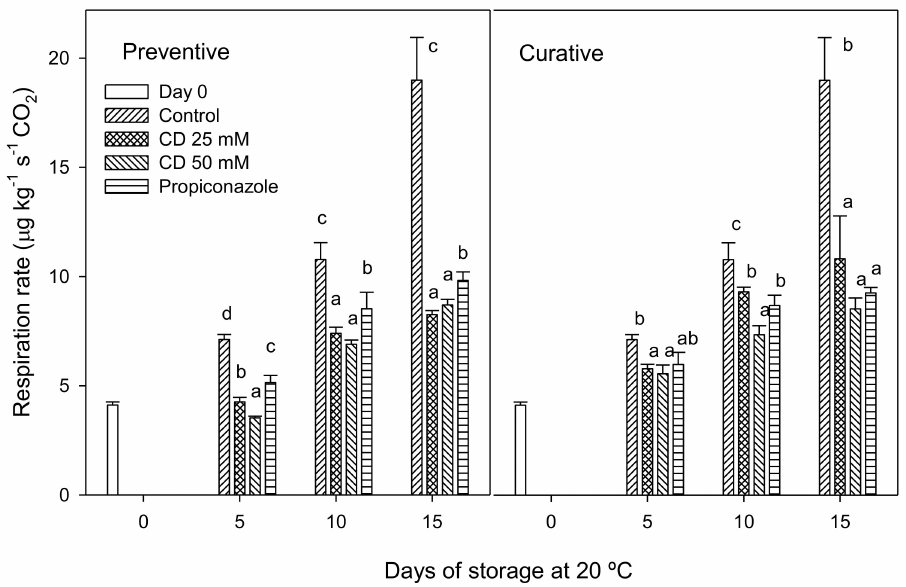
Figure 3. Weight loss (%) of “Fino 49” lemon fruit treated with 25 or 50 mM HP- β -CD-thymol or propiconazole during 15 d of storage at 20 ◦ C in preventive ( A ) and curative ( B ) experiments. Data are the mean ± SE. Di ff erent letters show significant di ff erences ( p < 0.05) among treatments for each sampling